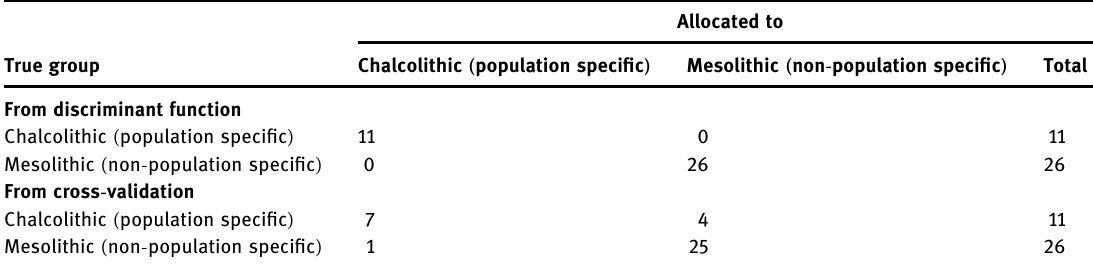
Table A6: DFA with cross - validation of the population - speci fi c reconstructed Chalcolithic sample vs the population - speci fi c reconstructed Mesolithic sample ( see details about reconstruction parameters in Materials and methods )